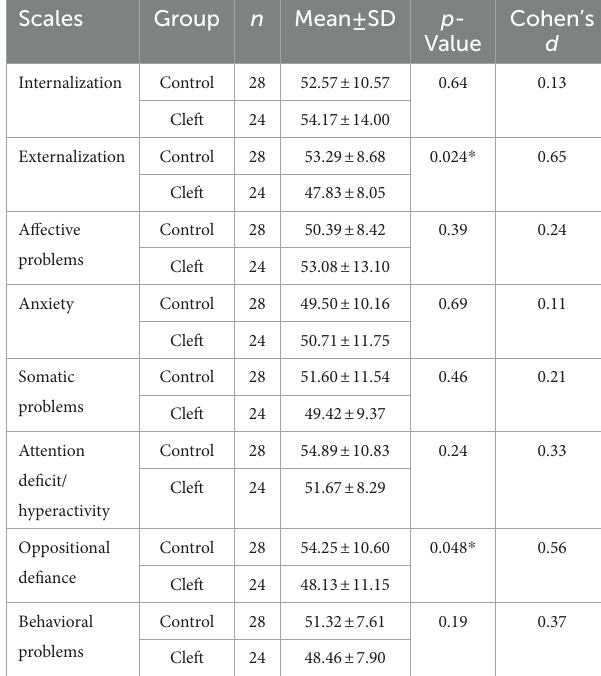
TABLE 3 Results of the CBCL self-report.